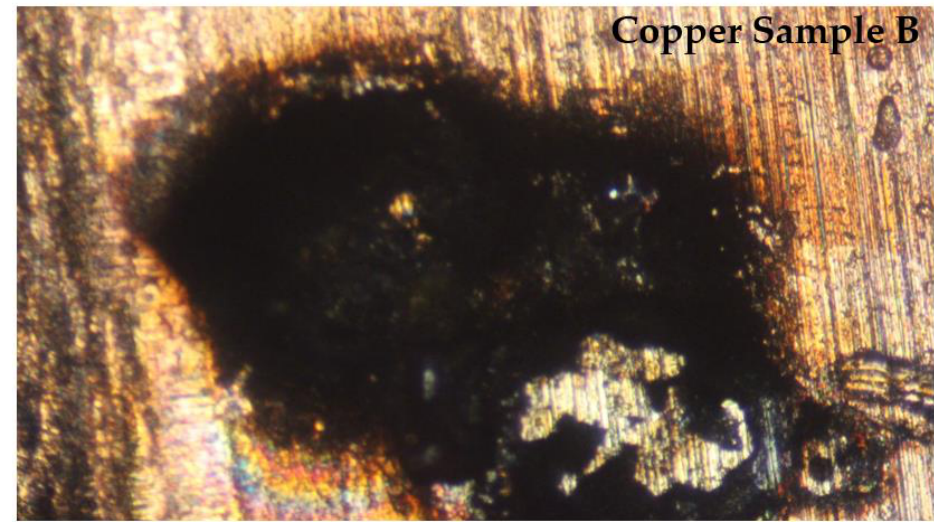
Figure 10. A new copper contact surface after being subjected to an electrical arc when 8.33 A of current passed through the contact. Notice that the black residue is much more apparent here than in the lower-current setup. Magnification at 20 × .